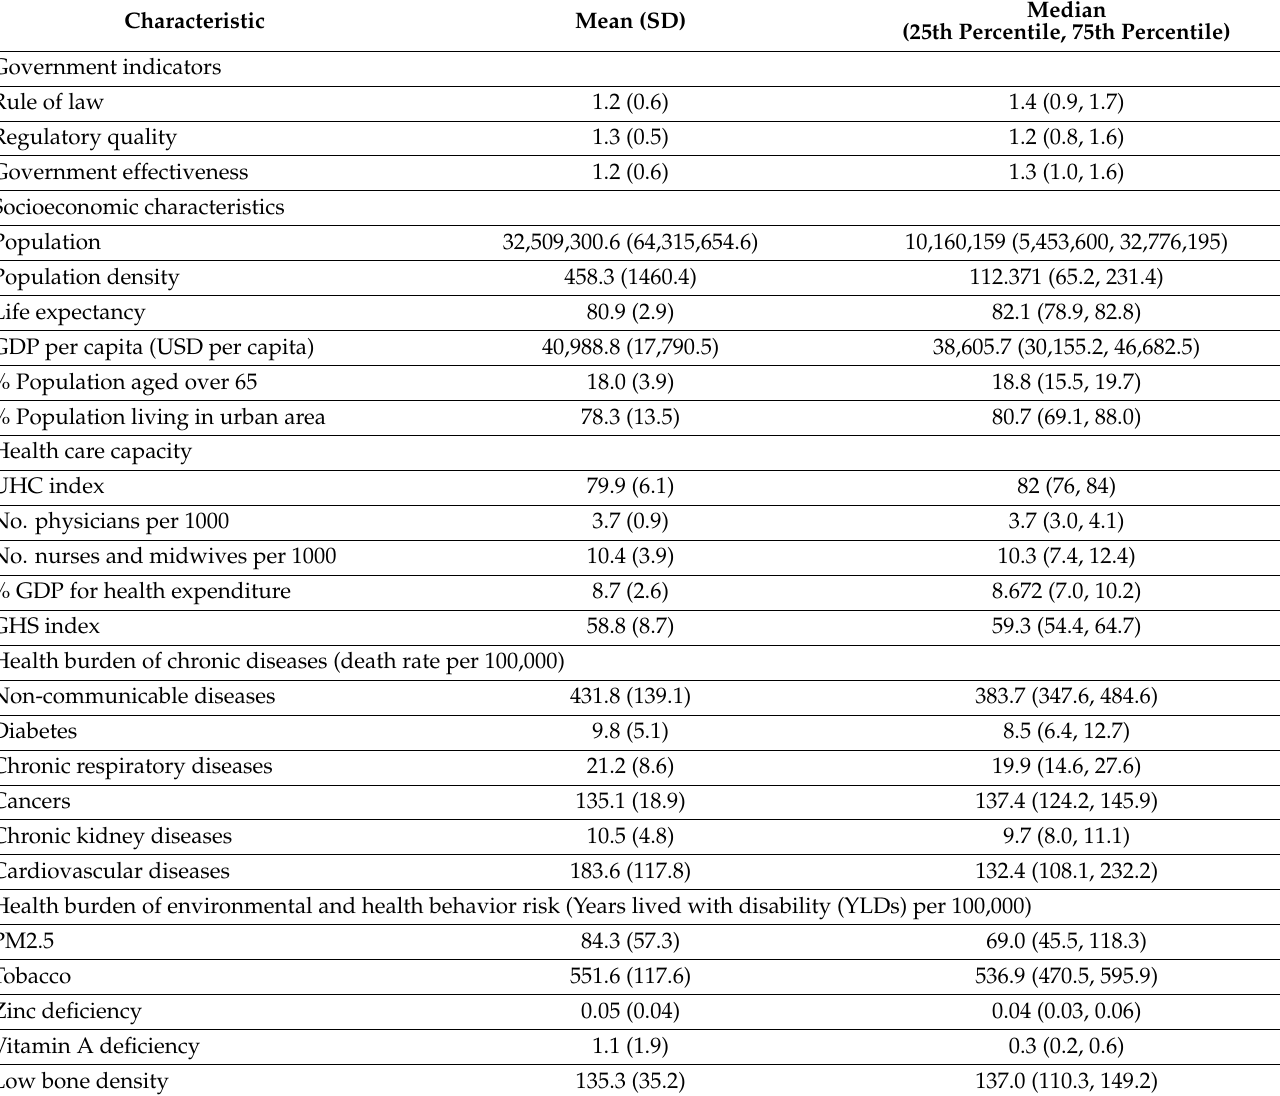
Table 1. The demographics of selected